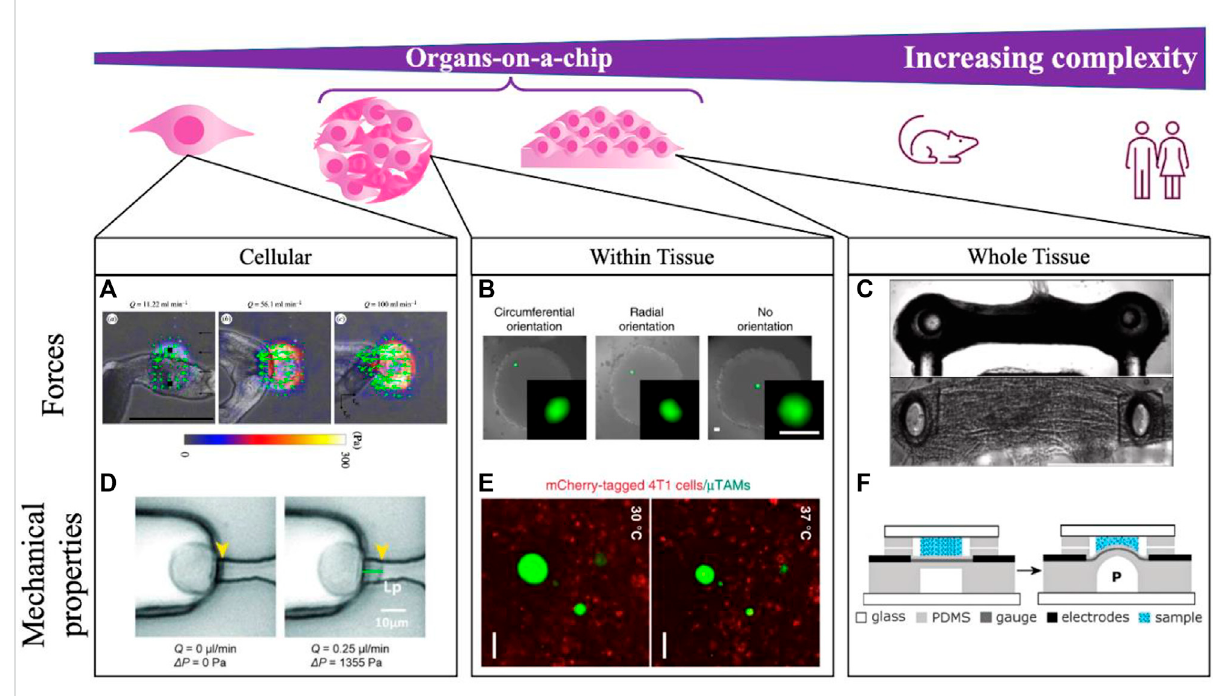
FIGURE 2 Integrating mechanical measurements on-a-chip can be done to study tissues spanning a range of complexities. Measurements are made at the single cell scale (A,D) , locally within self-assembled tissues (B,E) , and across whole dynamic tissues (C,F) . (A) Schistosoma mansoni generated forces are quanti fi ed by integrating TFM-on-a-chip and modulating a shear force applied to cells with fl owrate Q in the micro fl uidic channel. Scale bar500 μ m.ReprintedwithpermissionfromZhangetal.(2019),J.R.Soc.Interface16:20180675(2018).Copyright2018TheRoyalSociety(UK) (B) Within tissures, compliant hydrogel microdroplets deform under applied loads in a fi broblast multicellular spheroid, with bead orientation indicating the direction of applied cell-generated forces. Scale bare 50 μ m. Reprinted with permission from Lee et al. (2019), Nat. Commun. 10 ,